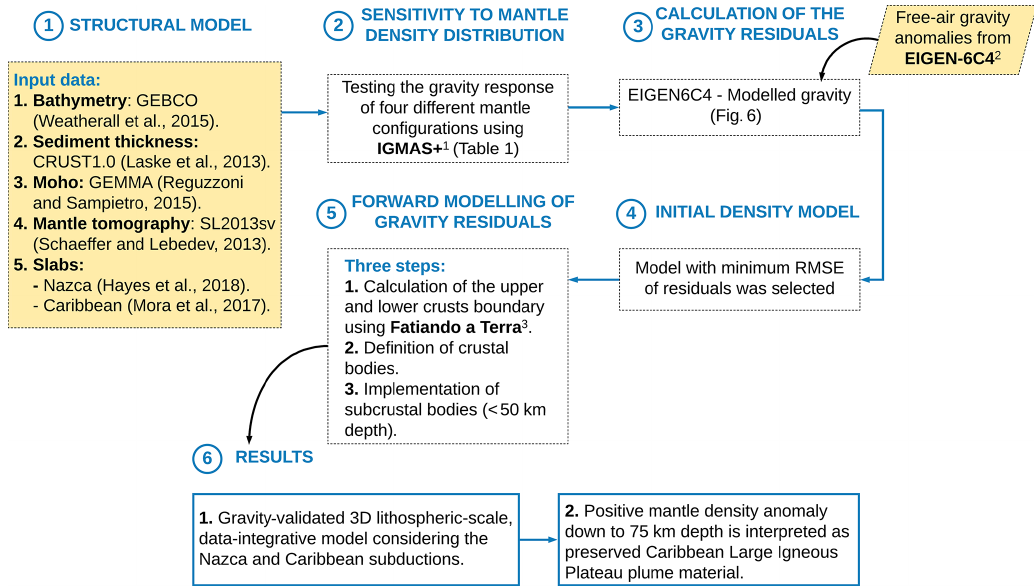
Figure 2. Methodological scheme used in this research. 1 Schmidt et al. (2011). 2 Förste et al. (2014) and Ince et al. (2019). 3 Uieda et al.